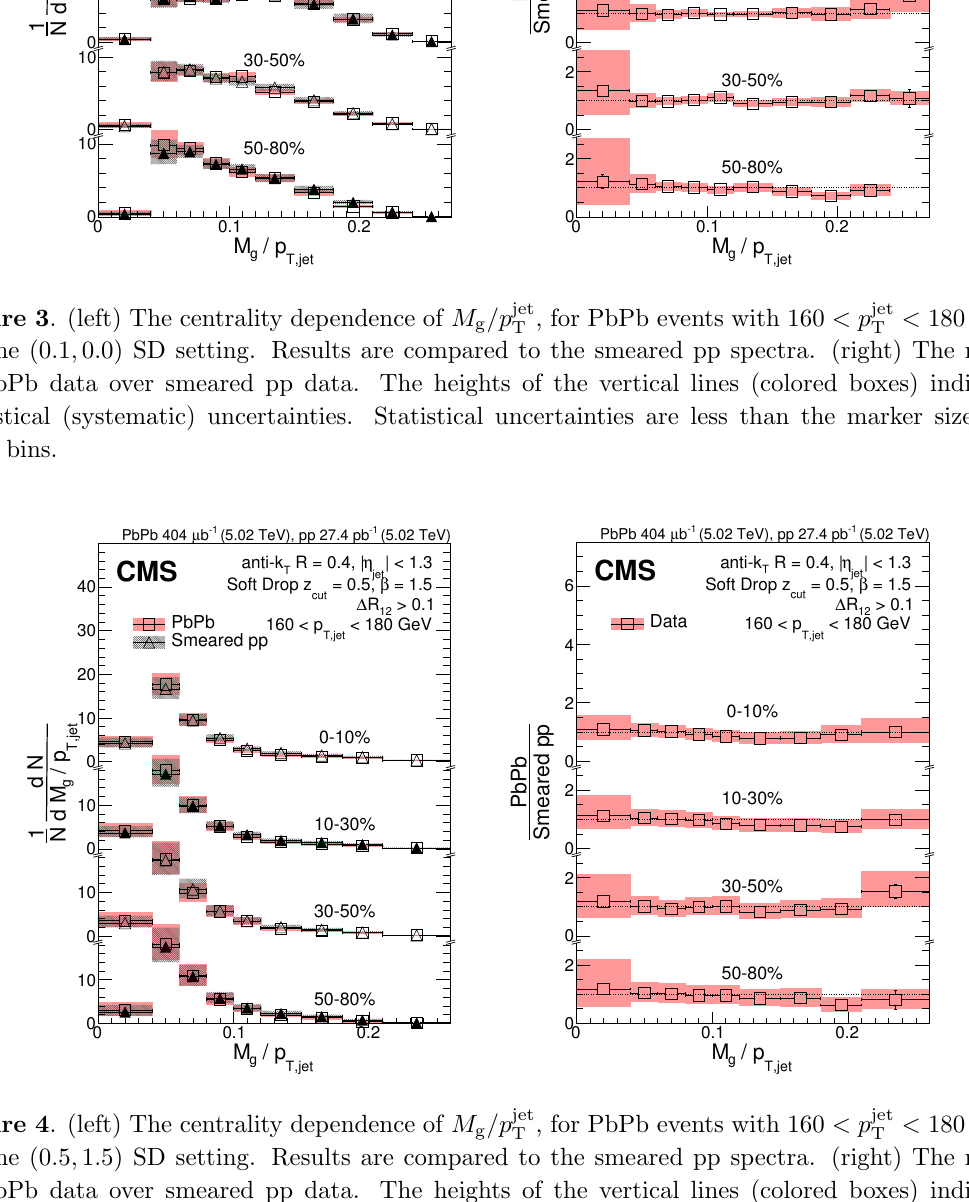
, for PbPb events with 160 < p jet < 180 GeV T T